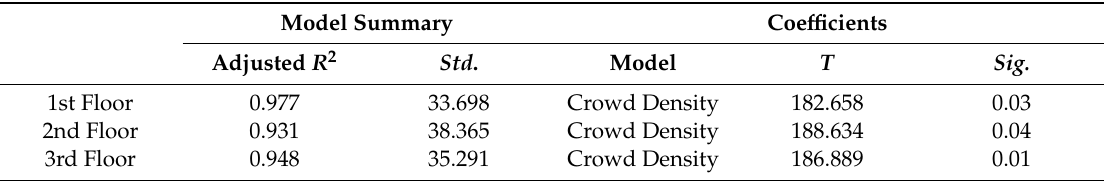
Table 2. Correlation analysis between the crowd density and the error in the stores.